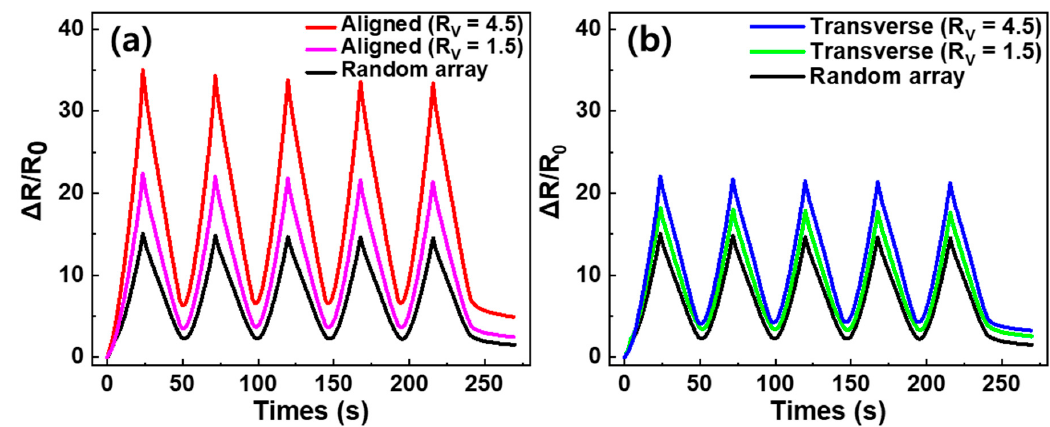
Figure 6. Comparison of CNT/PDMS composite by the degree of alignment. Cyclic test under tensile strains applied from 0 to 20% of the ( a ) aligned direction and ( b ) transverse direction.